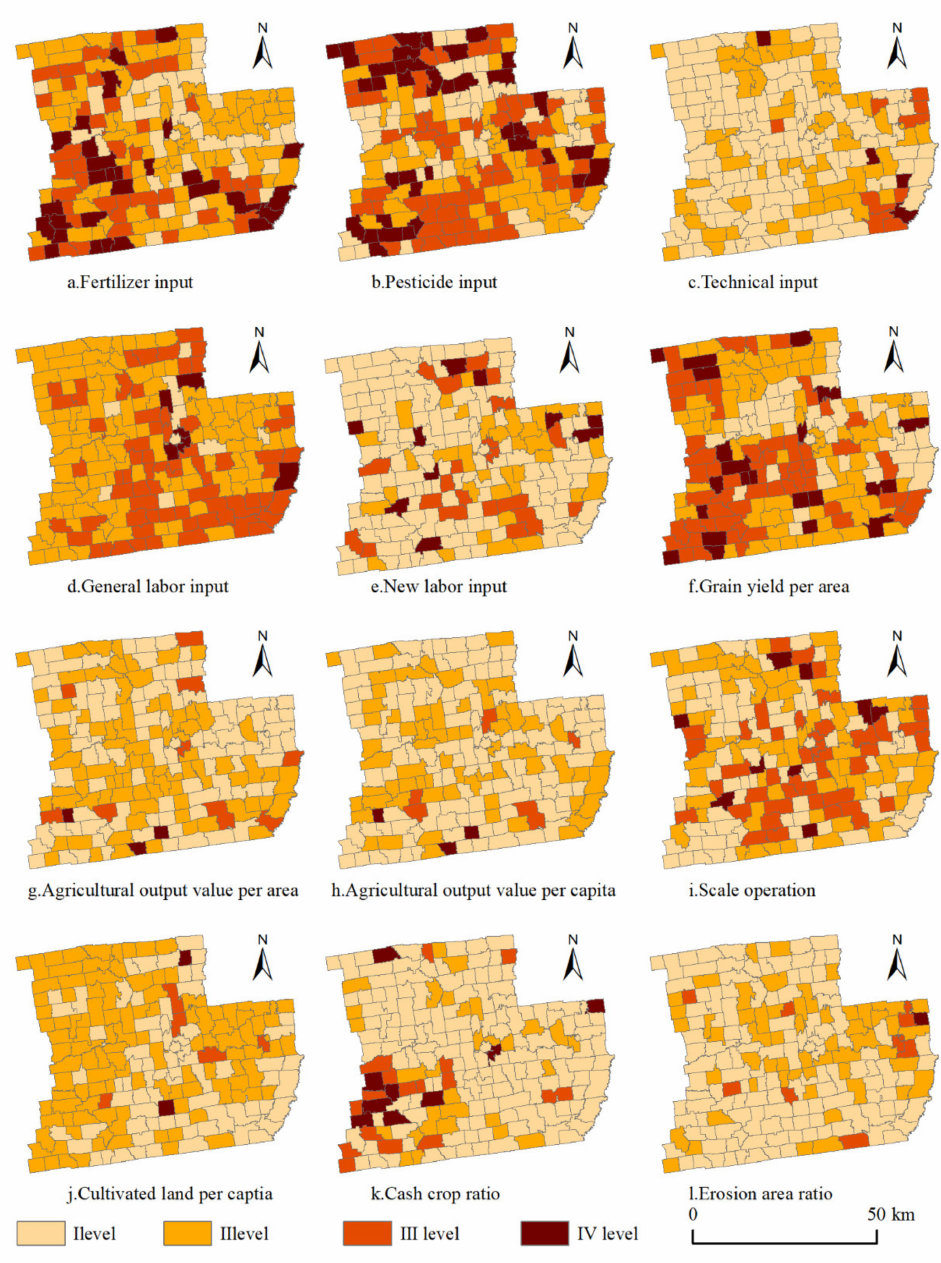
Figure 3. Indexes of cultivated land use intensification in